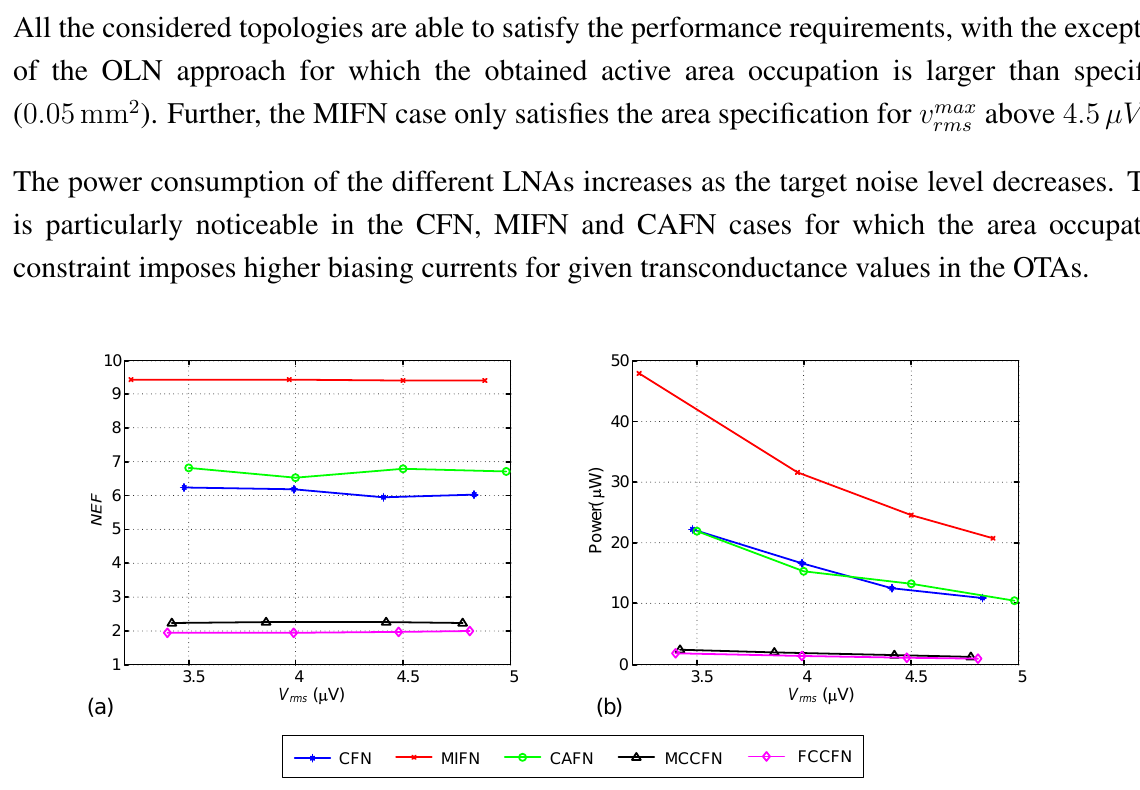
Figure 10. Synthesis results: ( a ) NEF ; ( b ) Area; and ( c ) Power versus required v